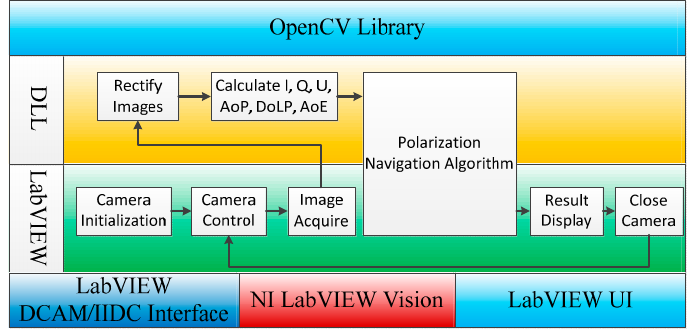
Figure 2. Flowchart of the primary process program.